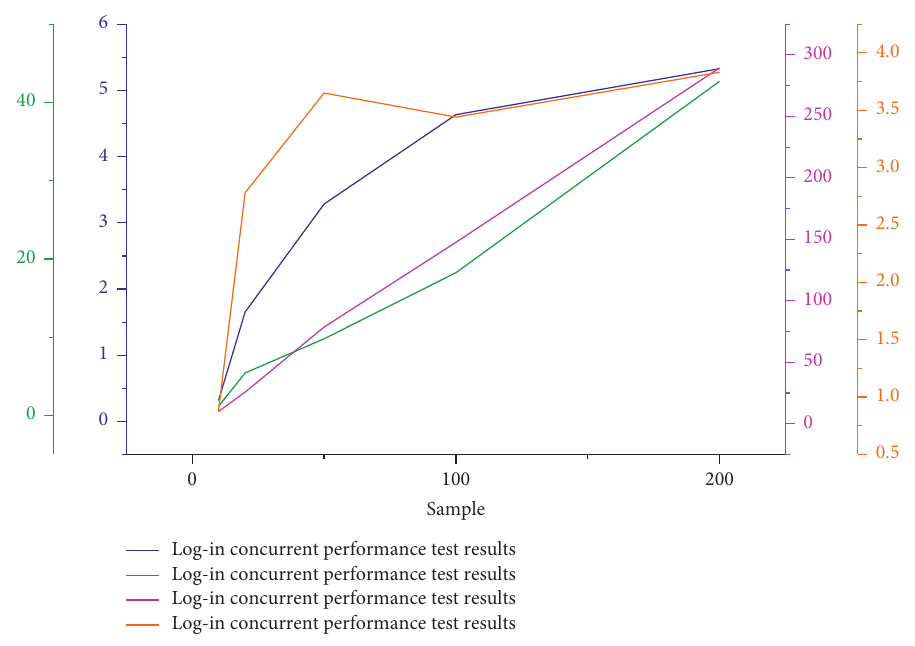
Figure 7: Login concurrency test results.